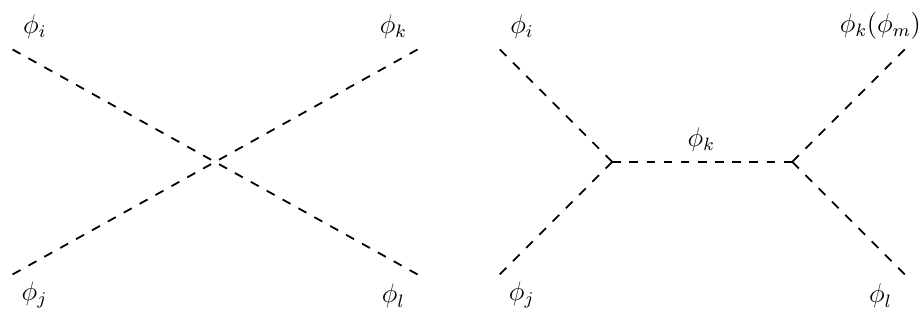
Figure 15 . DM conversion channels involving four or more DM (cid:12)elds. There exists also a t -channel diagram obtained from the s -channel